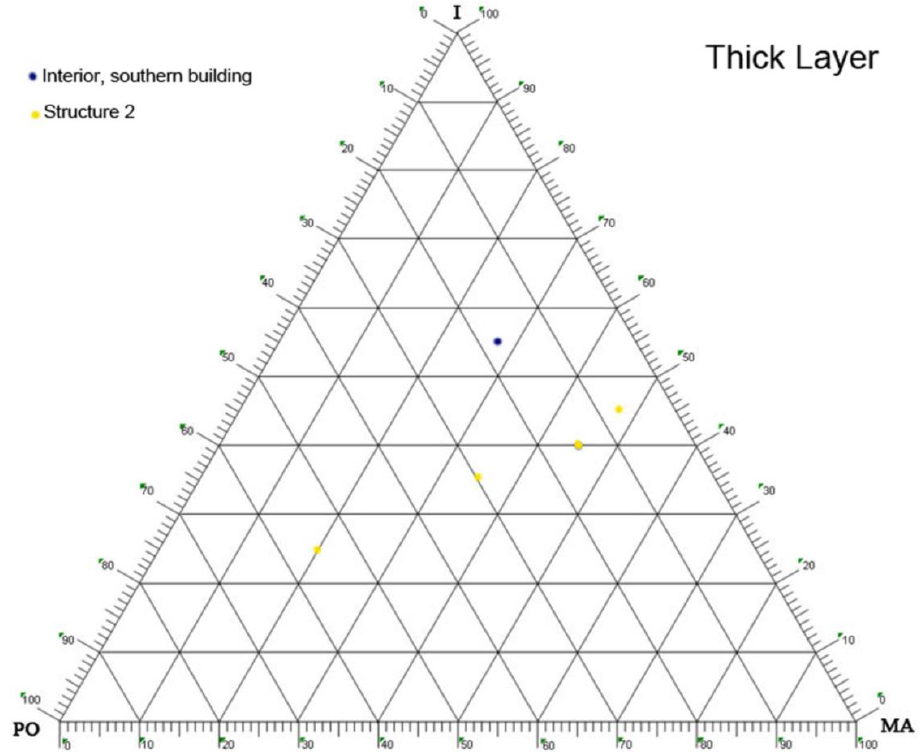
Figure 10. Ternary plot showing the proportions of inclusions, matrix, and porosity in the plasters of thick layers.